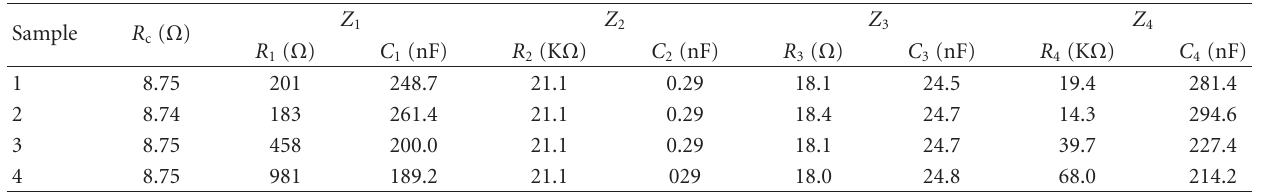
Table 4: Parameter of impedance spectra in a dark a-Si thin film solar cell with di ff erent volume fraction of B 2 H 6 in SiH 4 of p layer. Sample